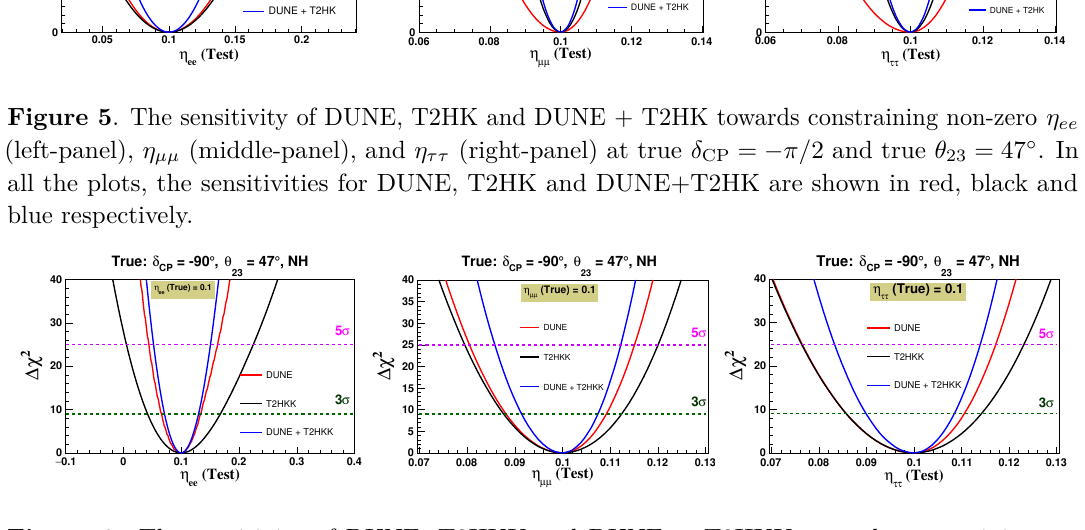
Figure 6 . The sensitivity of DUNE, T2HKK and DUNE + T2HKK towards constraining η ee (left-panel), η (middle-panel), and η (right-panel) at true δ = − π /2 and true θ = 47 ◦ . In µµ ττ CP 23 all the three plots the results for DUNE, T2HKK and DUNE+T2HKK are shown in red, black and blue